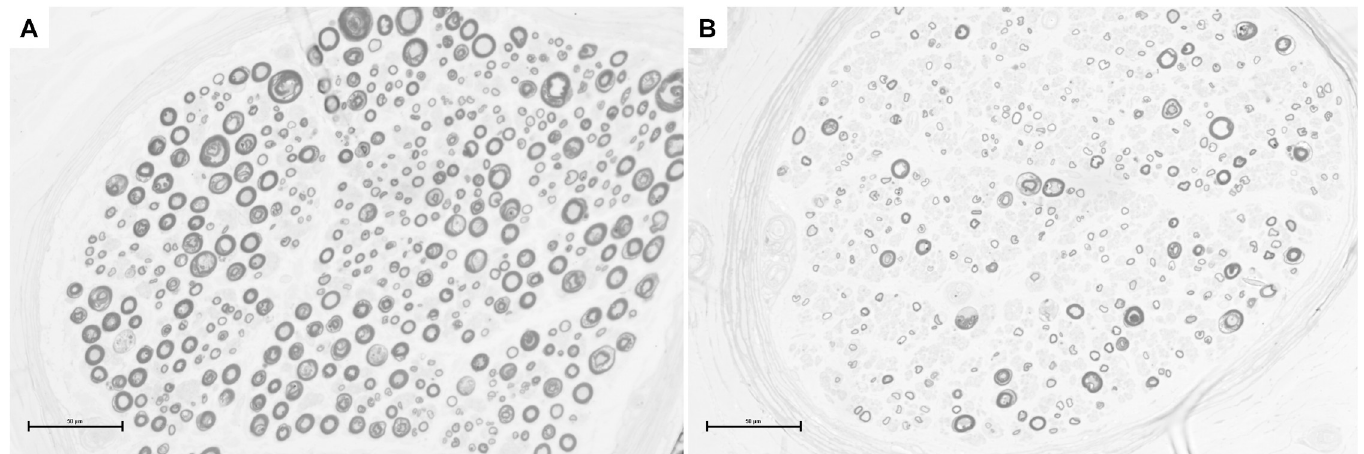
Fig 5. Nerve cross-sections for histomorphometric analysis of myelinated axons. A: Control sural nerve biopsy at 40x magnification. B: Sural nerve biopsy of a male, 68-year old patient presenting with paraprotein-associated chronic, axonal polyneuropathy (at 40x magnification). The number of myelinated axons and their density is significantly reduced. Scale bar represents 50 μ